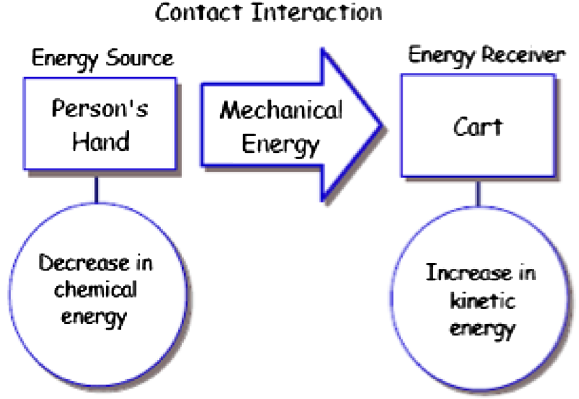
FIG. 1 (color online). Physics and Everyday Thinking (PET) energy diagram for a hand pushing a